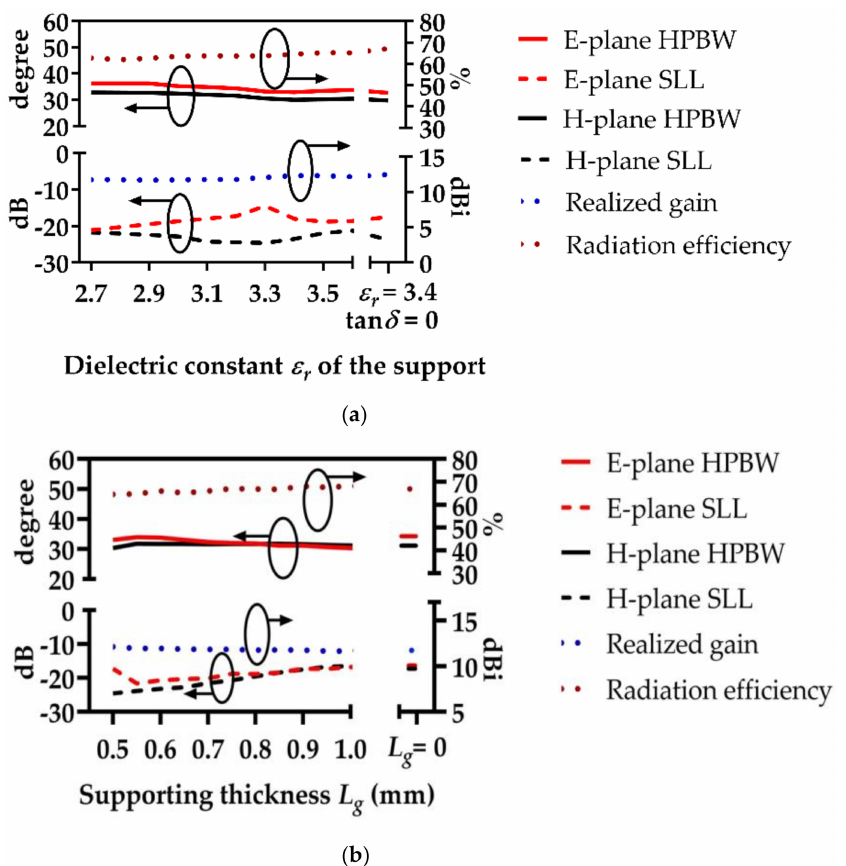
Figure 6. The study of the supporting material PLA on antenna performance. ( a ) The impact of the supports’ dielectric constant; ( b ) the impact of the supporting thickness L g .